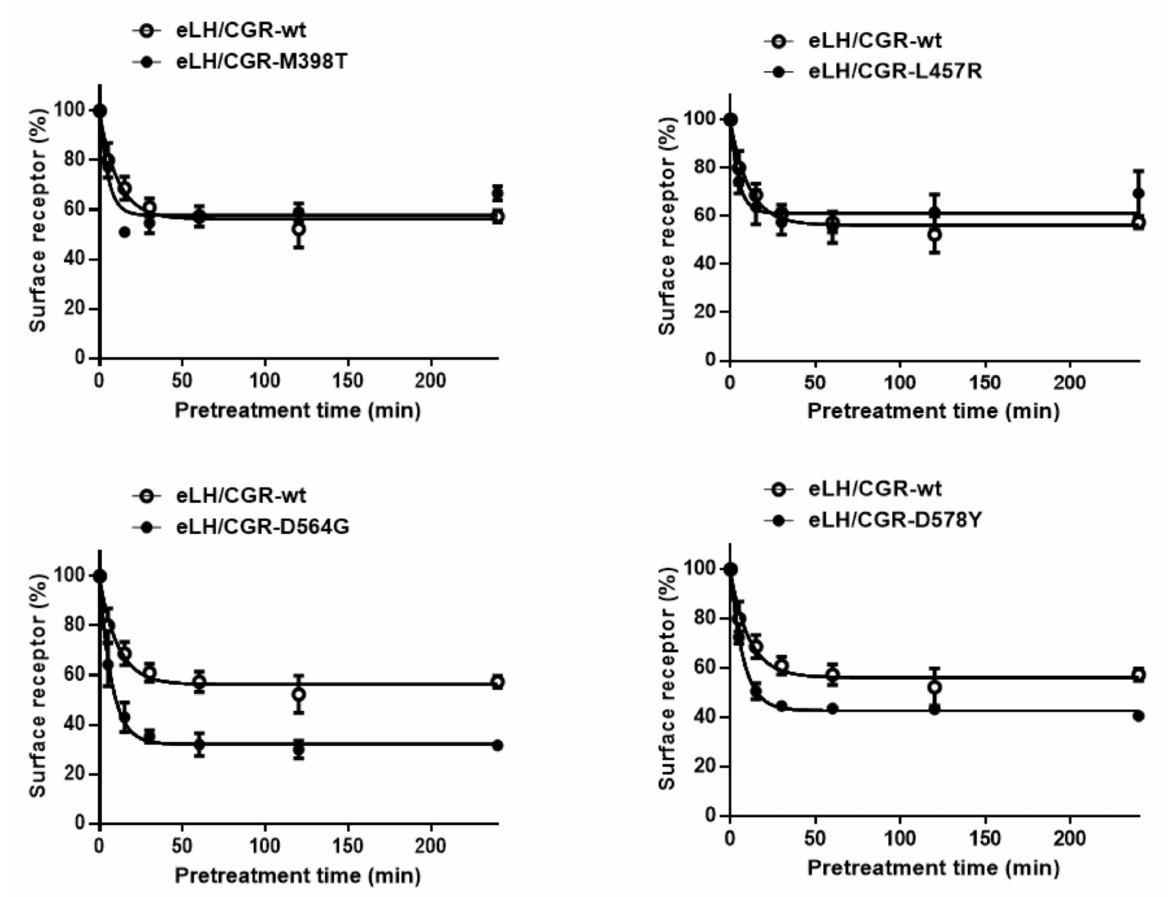
Figure 6. Time-dependent cell-surface loss in the wild-type eLH/CGR and activating eLH/CGR mutants. HEK-293 cells transiently expressing wild-type eLH/CGR or activating receptors (M398T, L457R, D564G, and D578Y) were incubated with 1000 ng/mL recombinant eCG (rec-eCG) for up to 240 min. Cell-surface expression in the non-pretreated groups was considered as 100% (see Materials and Methods for details). The loss of each receptor was determined using the GraphPad Prism software. The results are expressed as the means ± SE of three independent experiments. In this figure, the mean data are fitted to the one-phase exponential decay equation. The empty circles represent the corresponding curves for the wild-type